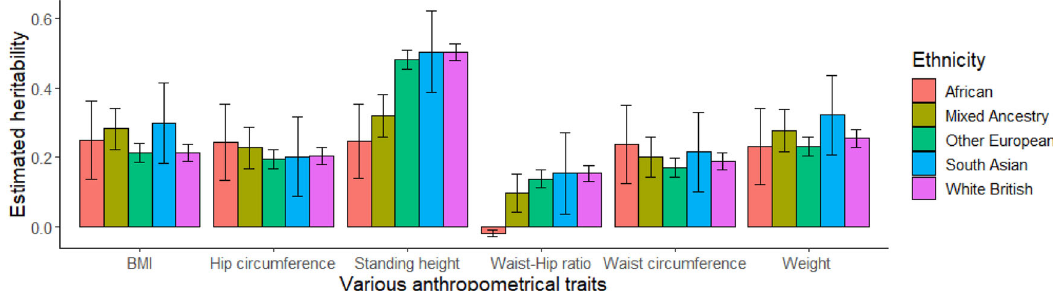
Fig. 4 | Estimated SNP-based heritability for different anthropometric traits across ancestries. The main bars indicate estimated SNP-based heritabilities, and theerrorbarsindicate95%con fi denceintervals(CI)thatwerederivedfromalinear